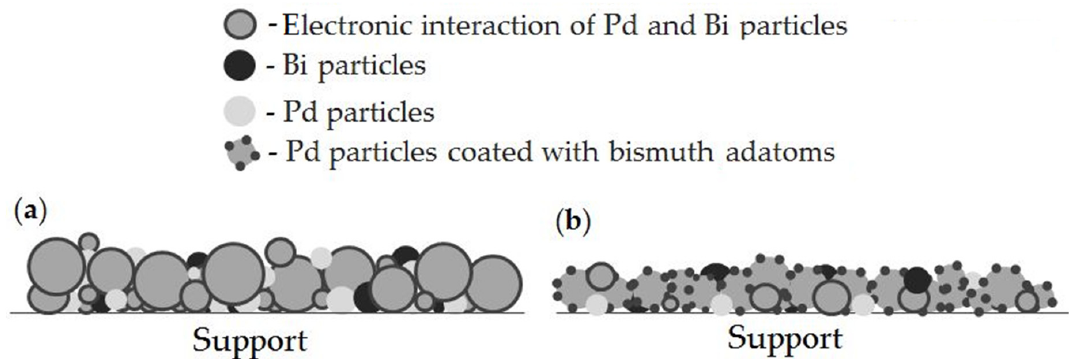
Figure 11. Mechanism of formation of particles on the surface of the support: ( a ) PdBi/Al 2 O 3 , ( b ) Pd → Bi/Al 2 O 3 .